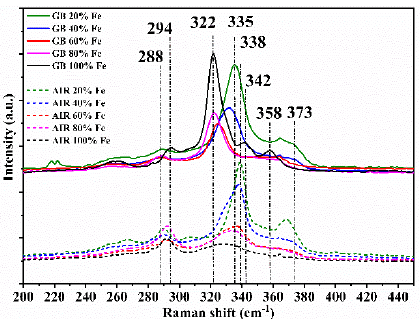
Figure 3. Raman spectra of the 20%, 40%, 60%, 80%, and 100% C(Z,F)TS thin films, made in glovebox and air. The secondary-phase iron pyrite FeS 2 disappears, adding 20% zinc to CFTS, and producing the stable stannite mineral structure Cu 2 Zn 0.2 Fe 0.8 SnS 4 [7]. The critical importance of controlling the